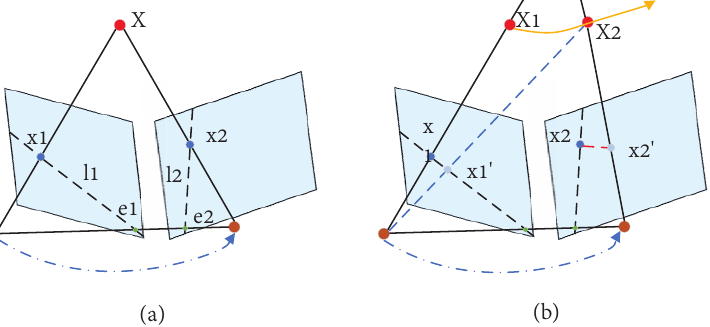
Figure 23. Traditional methods use geometric constraints to judge whether an object is moving or not. For example, in ( a ), X is a static point in space, so the spatial transformation relation can be obtained smoothly. In ( b ), the motion of space point X1 will bring systematic error after it moves to X2.